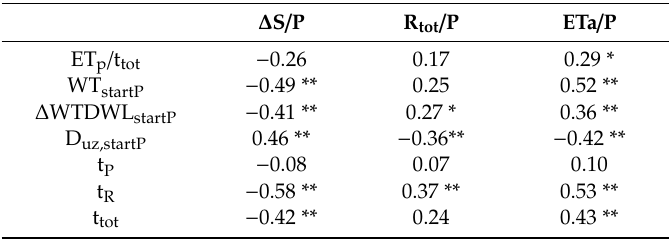
Table 2. Kendall’s τ between the ratios of the water budget components to P (ΔS/P, R tot /P, ETa/P) and the boundary conditions during the evaluated periods. Values refer to the period Δt tot or the time indicated (*: p > 0.05, **: p > 0.01).